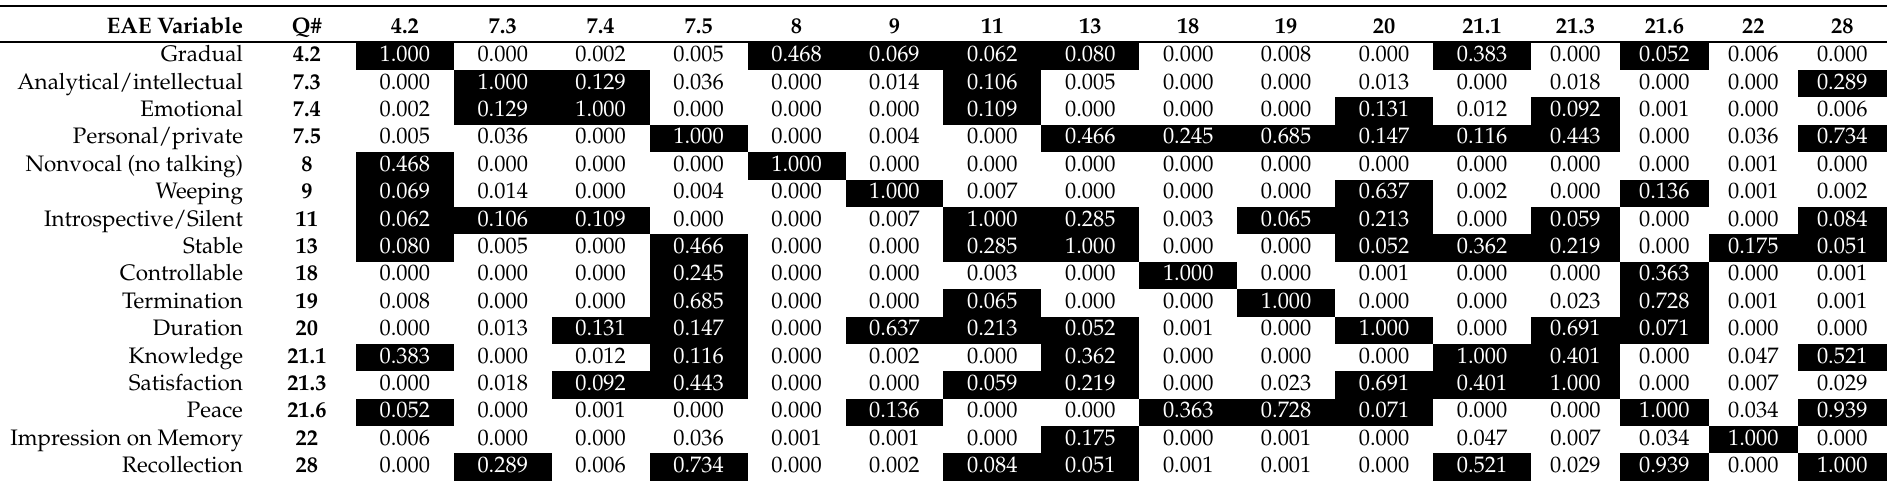
Table A3. Chi-Square test correlation matrix for “extraordinary architectural experience” (EAE) variables from Bermudez’s survey database and reorganized under Jones’ “sanctuary” category for ritual contexts. Any variable with a white background (not black) is considered a statistically significant